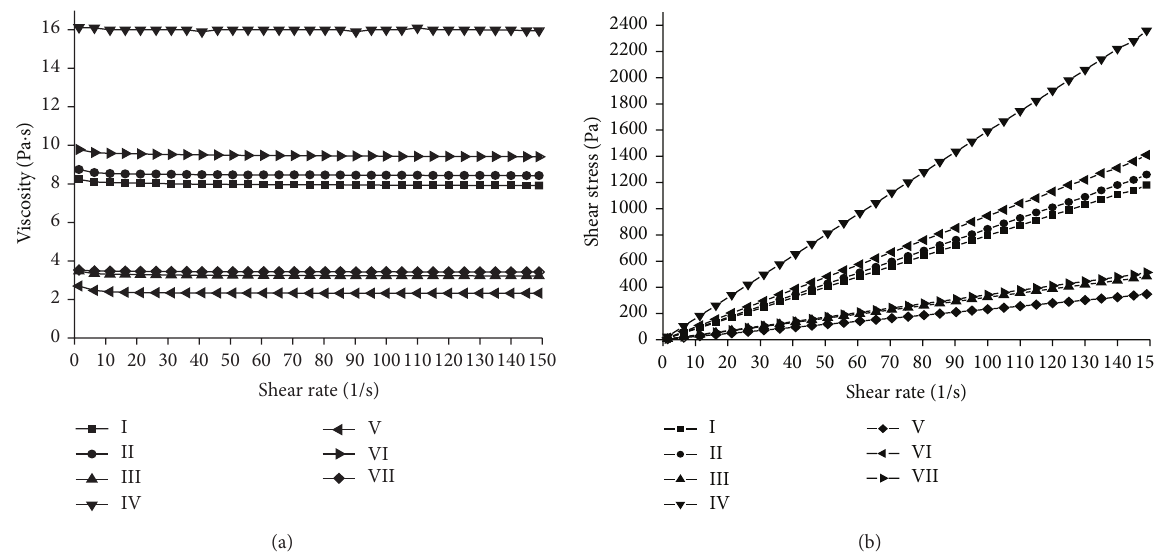
Figure 2: (a) Viscosity of honey as a function of shear rate at the temperature of 25 ∘ C. (b) Shear stress for honey at variable shear rates at 25 ∘ C.